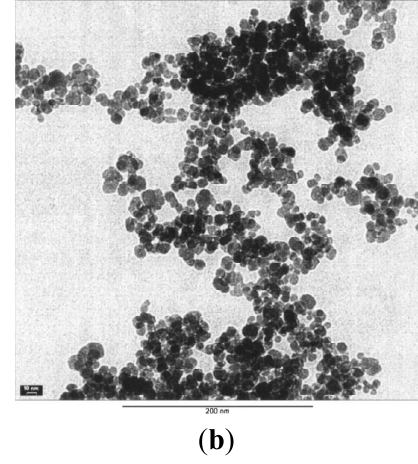
Figure 6. Transmission electron micrographs for magnetic iron oxide precipitated in: ( a ) water alone; ( b ) the presence of poly(ethylene oxide) (PEO) homopolymer; and ( c ) the presence of PEO- b -poly(methacrylic acid) (PMAA) block copolymer. Note that Figure 6c is at somewhat higher magnification than the others; ( d ) magnetization curves for the PEO- b -PMAA coated NPs and for P(HEMA- co -MMA) magnetic latexes obtained by inversion emulsion polymerization. Reprinted with permission from [28]. Copyright 2001